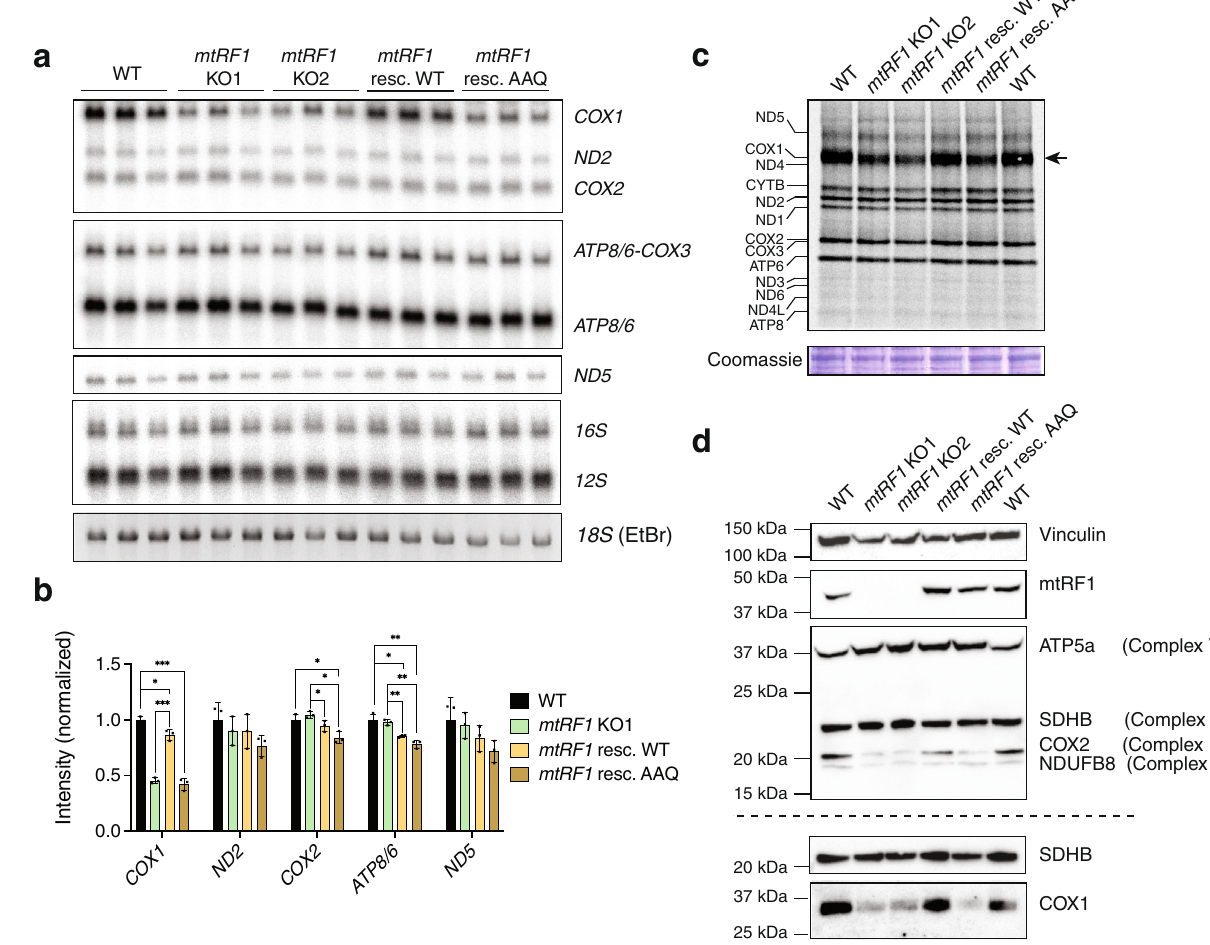
Fig. 4 | GGQ motif of mtRF1 is essential for its function. a Mitochondrial tran- script levels of mtRF1 rescue cells (WT and AAQ mutant) compared to mtRF1 KO and WT cells analyzed by northern blotting (the same membrane as in Fig. 2a is shown). Each sample is represented by three biological replicates. Several tran- scriptswereprobedononemembrane.Loadingwasassessedbyethidiumbromide (EtBr) staining of the gel (18S rRNA band) and 16S probing. b Quanti fi cation of a normalized to transcript levels in WT cells. To account for different loading, all bandintensitieswere fi rstnormalizedto16Slevels.MeansandSDof n =3biological replicates. Unpaired two-tailed t-test of rescue cells compared to WT and mtRF1 KO1 cells. (* P <0.05; ** P <0.01; *** P <0.001). c De novo synthesis of mitochondrial